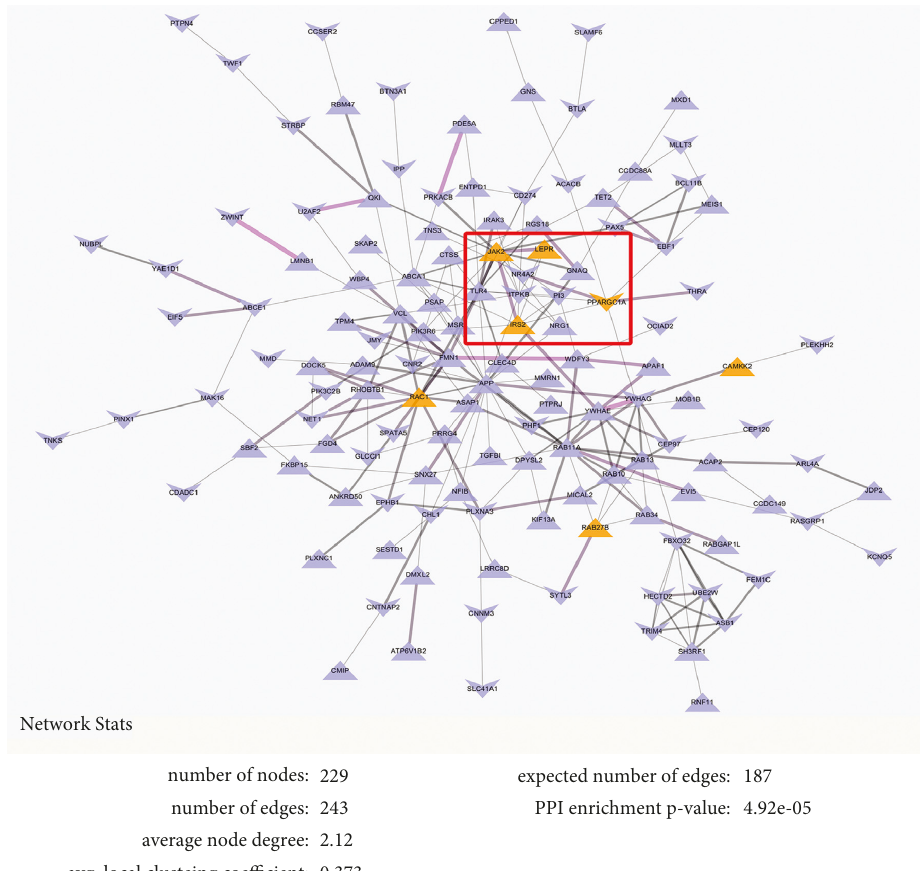
Figure 5: Construction of PPI network. The protein-protein interaction (PPI) network was constructed via Search Tool for the Retrieval of Interacting Genes (STRING) and visualized by Cytoscape software. A confidence score